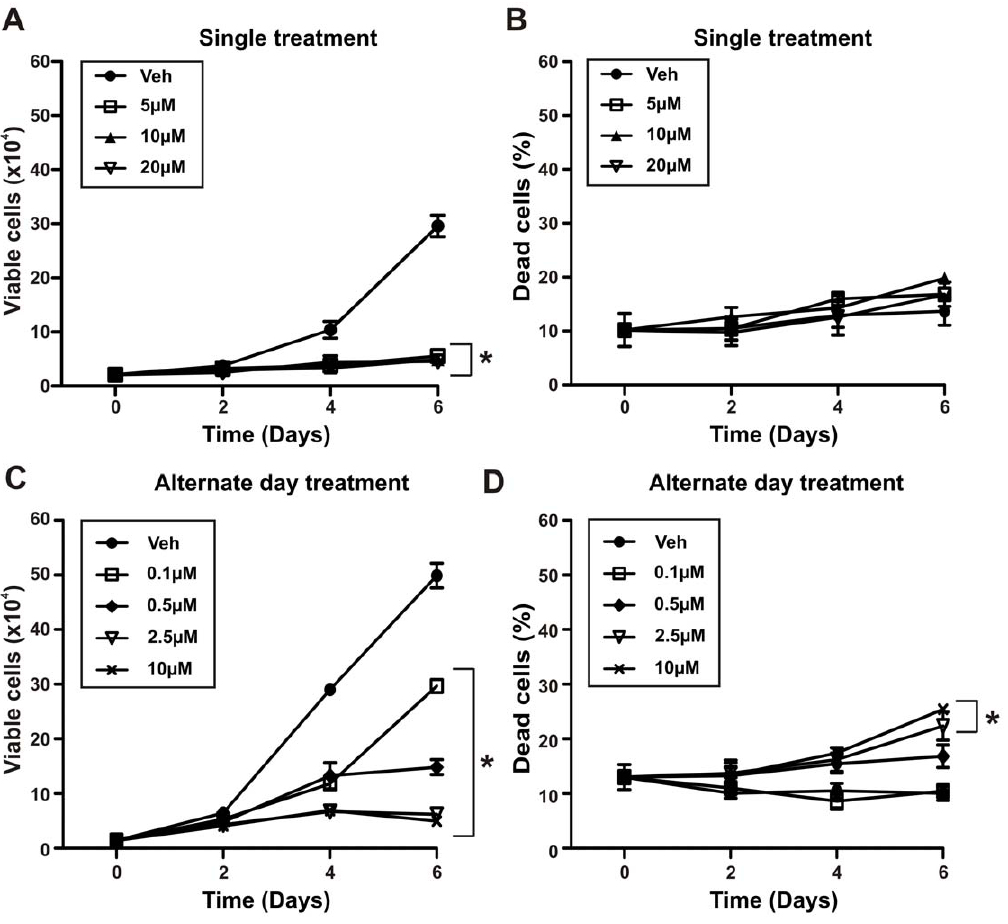
Figure 1. Single and alternate day 5-aza-CdR treatment of LNCaP prostate cancer cells. LNCaP prostate cancer cells (2.5 6 10 4 cells per well in 24-well plates) were treated with increasing doses of 5-aza-CdR (5–20 m M) administered (A–B) once on day 0 or (C–D) with increasing doses of 5- aza-CdR (0.1-10 m M) replenished on alternate days for up to 6 days. (A) and (C) cells were counted at regular intervals using a hemocytometer and the number of viable cells was assessed by Trypan blue dye exclusion. (B) and (D) the number of dead cells is expressed as a percentage of the total number of cells counted. Data at each time-point represents the mean + / 2 SE of triplicate wells. *Two-way ANOVA: p , 0.0001 for (A), (C) and (D) (10 m M); p , 0.001 for (D) (2.5 m M) when compared to vehicle control (veh) on last day of treatment.